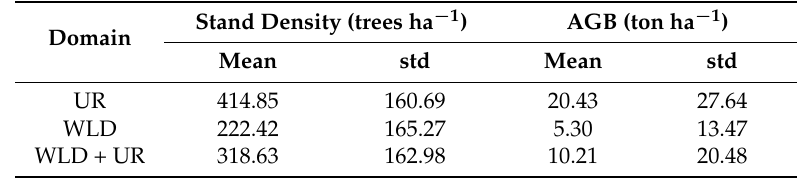
Table 5. Tree stand density (trees ha − 1 ) and AGB (ton ha − 1 ) in the UR, WLD and total burnt area (UR + WLD).